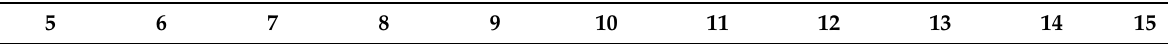
Table 2. Correlations of all of the variables examined in the study among video games